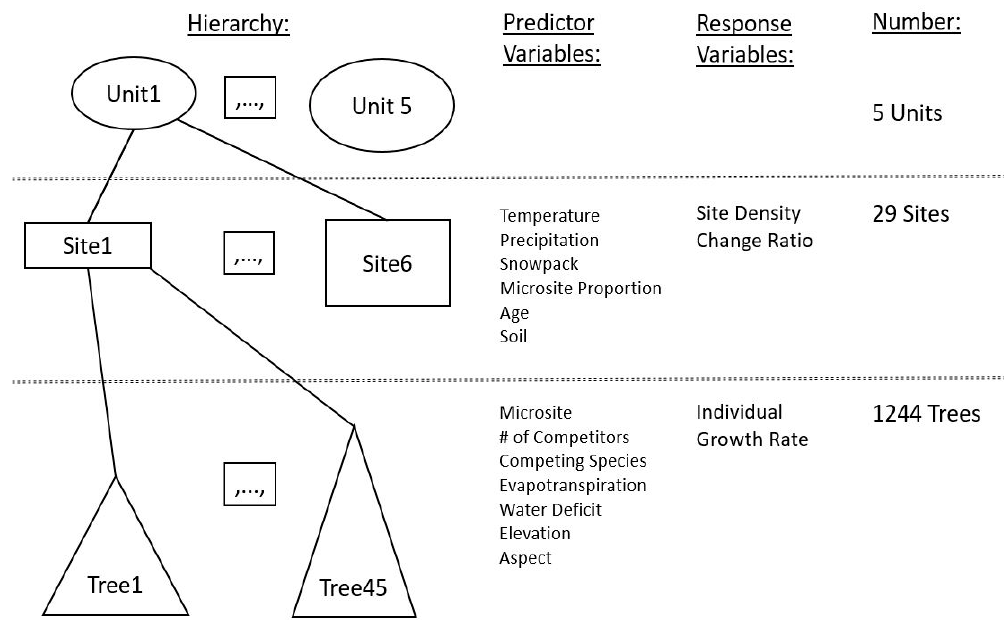
Figure 2. Hierarchical study design, predictor variables, and sample sizes.